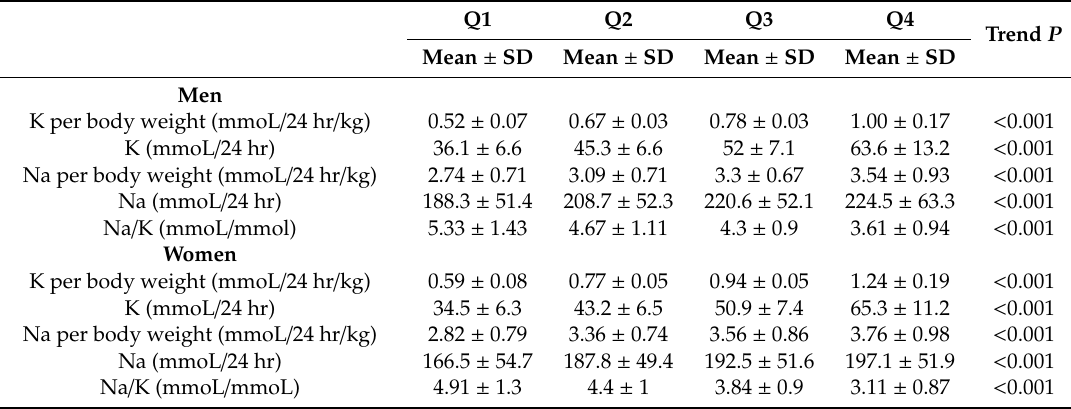
Table 3. Electrolyte excretion from 24-hr urine of participants stratified by quartiles of 24-hr